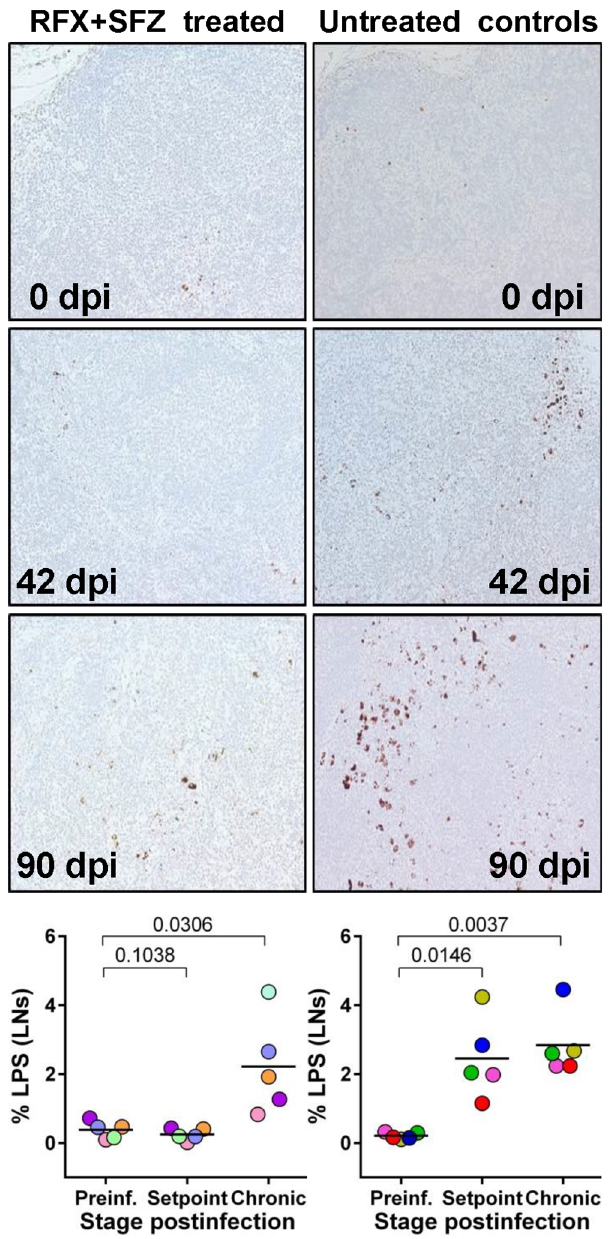
Fig 2. Comparison between the levels of microbial translocation in axillary lymph nodes (LNs) of SIVsab-infected PTMs receiving RFX+SFZ and untreated controls. Representative images (50x) of the LNs stained for LPS-core antigen (brown) collected prior to infection, at the set-point and at the end of treatment. Note the extensive accumulation of microbial products within the macrophages located around the subcapsular and medullary sinuses, and in the paracortical parenchyma of the lymphatic tissues in untreated controls, and moderate increase in LPS levels in LNs of PTMs treated with RFX+SFZ. Quantification of the percent area of the LN positive for LPS. P values are based on the Mann – Whitney test. Graphs show group means at critical times of SIV infection, with individual animal data points